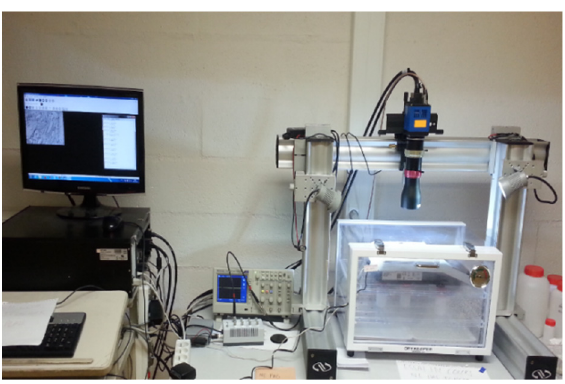
Figure 1. Developed experimental device of DIC.